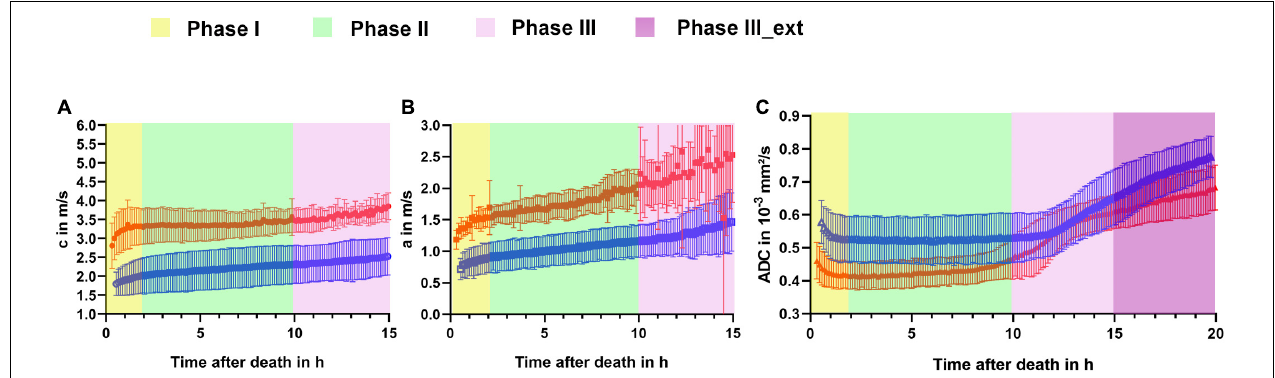
FIGURE 2 | Temporal evolution curves of group averages and standard deviations of (A) shear wave speed c , (B) penetration rate a , and (C) apparent diffusion coefficient ADC of non-perfused (red curve) and perfused (blue curve) liver with different colors indicating phases as defined in the text. NPL, non-perfused liver; PL, perfused